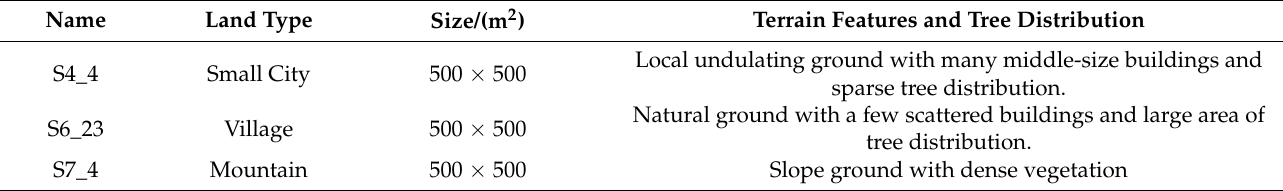
Table 1. Details of selected plots from OpenGF.